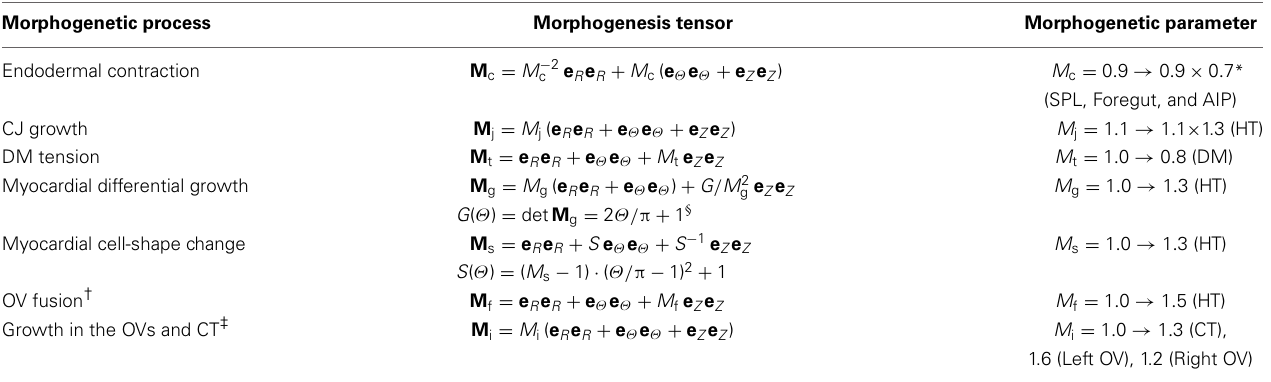
Table 1 | Morphogenetic processes in baseline